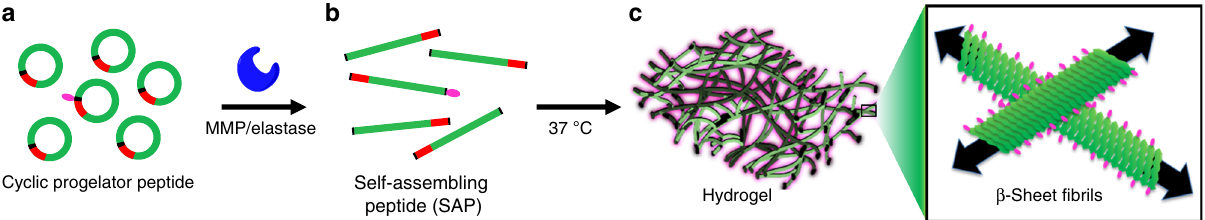
Fig. 1 Design of cyclic, enzyme-responsive progelator peptides for activatable gelation. a Cyclic progelator peptides, containing gelling sequence (green), matrix metalloproteinase (MMP)/elastase enzyme cleavage recognition sequence (red), and disul fi de bridge (black), resist assembly due to conformational constraint. Rhodamine-labeled (pink ellipse) self-assembling peptides (SAPs) were employed for in vivo studies as a 5 mol% additive to provide a means for imaging the hydrogels in ex vivo microscopy analyses. b Enzymatic cleavage results in linearization into SAPs. c SAPs assemble into viscoelastic hydrogels composed of β -sheets fi brils